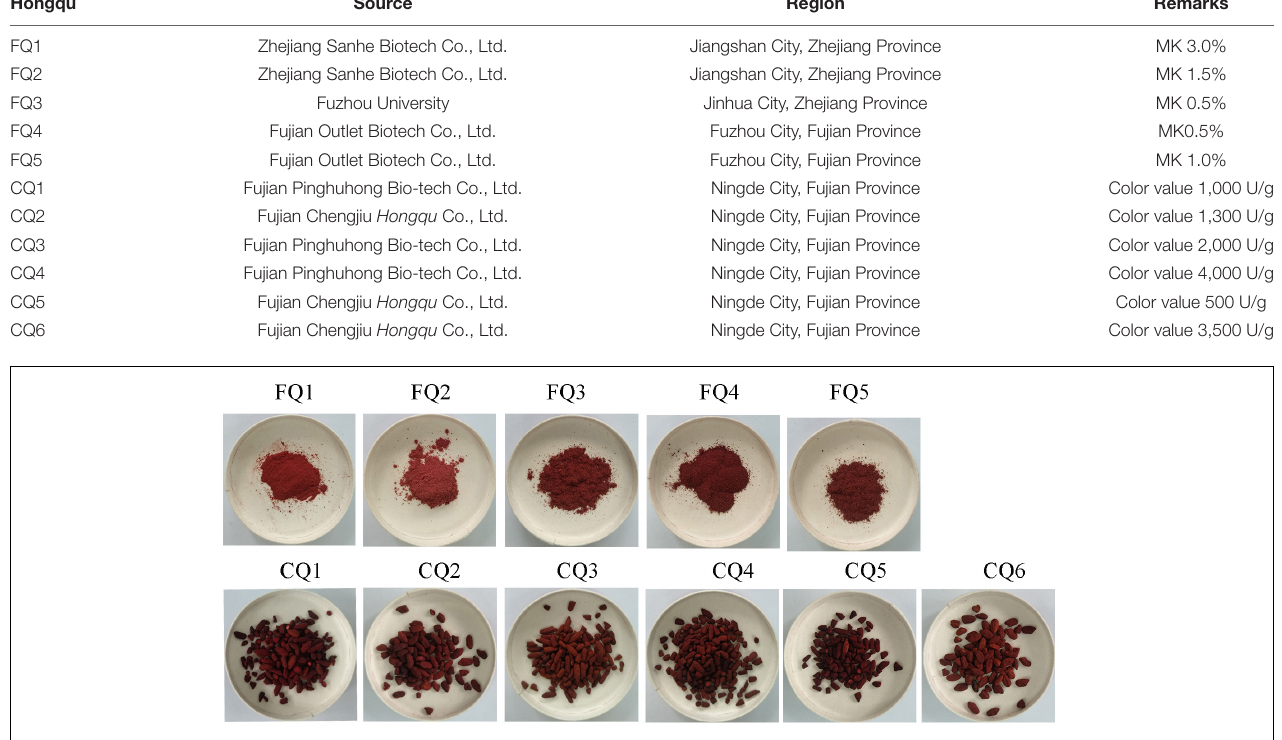
FIGURE 1 | Appearance of Hongqu . FQ1–FQ5 were functional Qu (FQ). CQ1–CQ6 were coloring Qu (CQ).